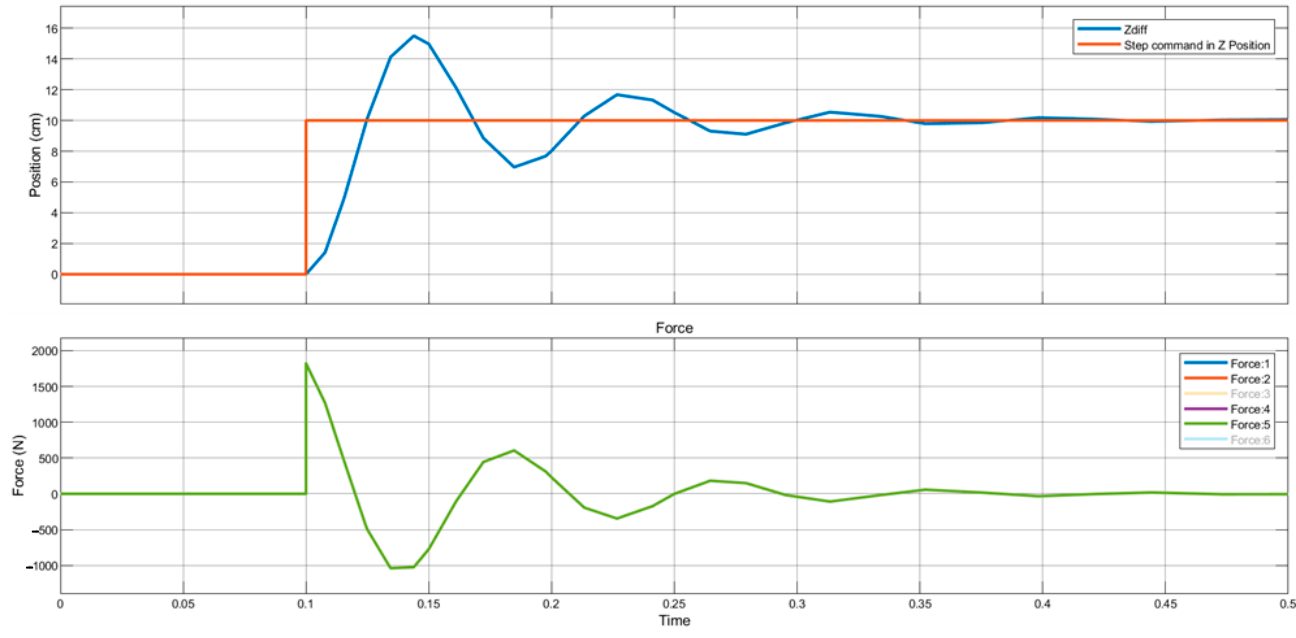
Figure 13. PID controller step input response and force on six legs during simulation time.